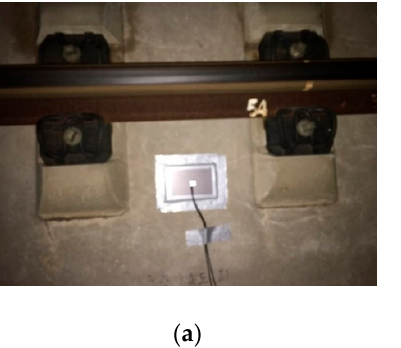
Figure 4. Overview of accelerometers installation. ( a ) Accelerometer; ( b ) Overview of measurement site.